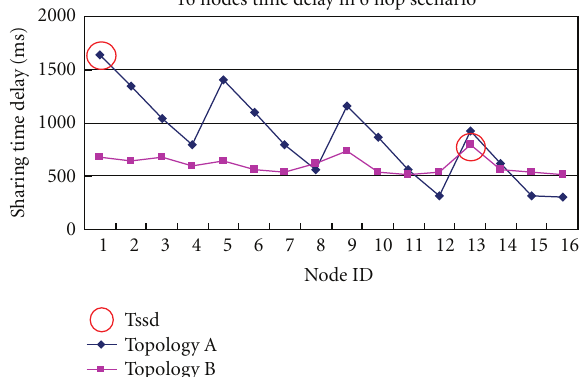
Figure 13: Mobile scenario (after exchanging positions of node 6 and node16 as well as the positions of node8 and node14, the network topology turns to Topology B).